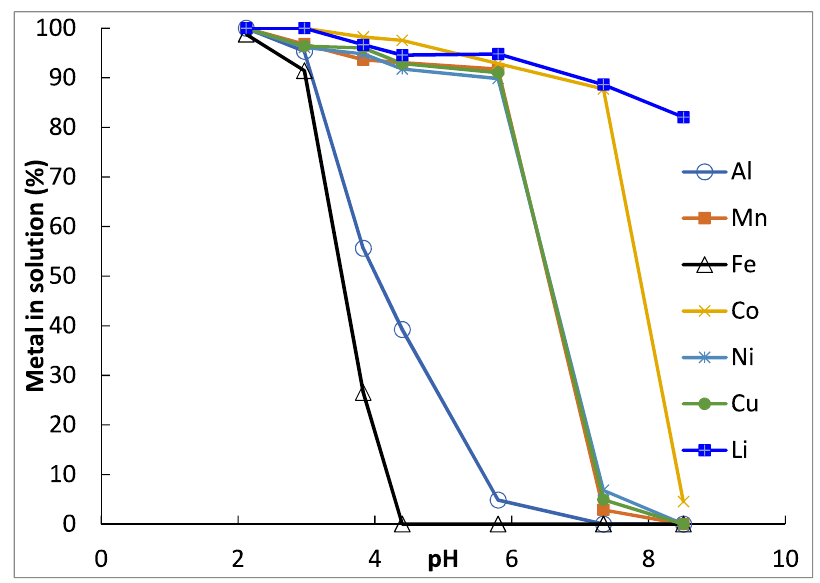
Figure 2. Metal precipitation from PLS using 2 M NaOH at 40 ◦ C.